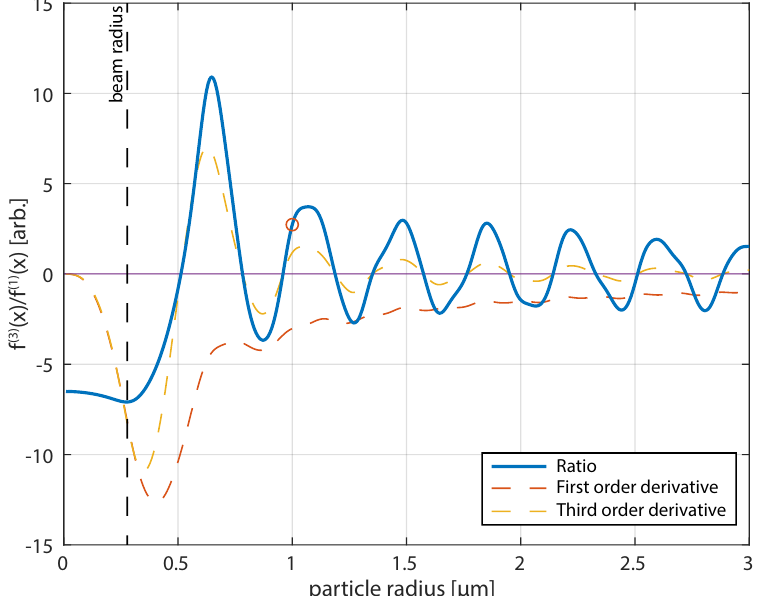
Figure 7. Ratio of first- and third-order derivative as a function of polystyrene particle radius in arbitrary units. The red circle denotes the particle size used in this study. The dashed lines denote the scaled first- and negative third-order